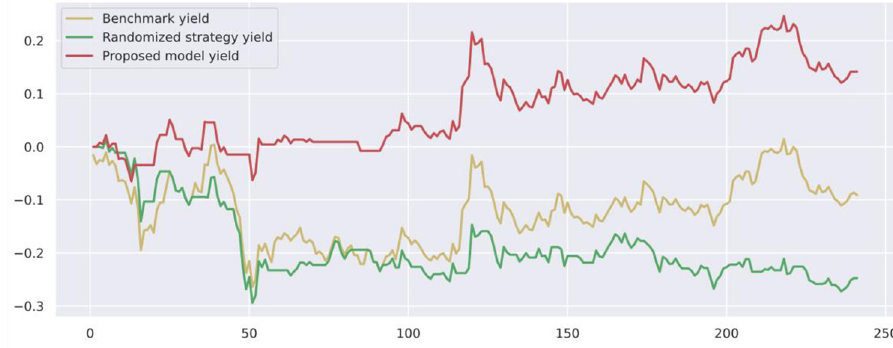
Fig 13. Vanke A stock strategy returns.